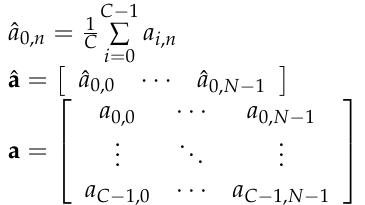
or sigmoid function, is not available in the skip connection.